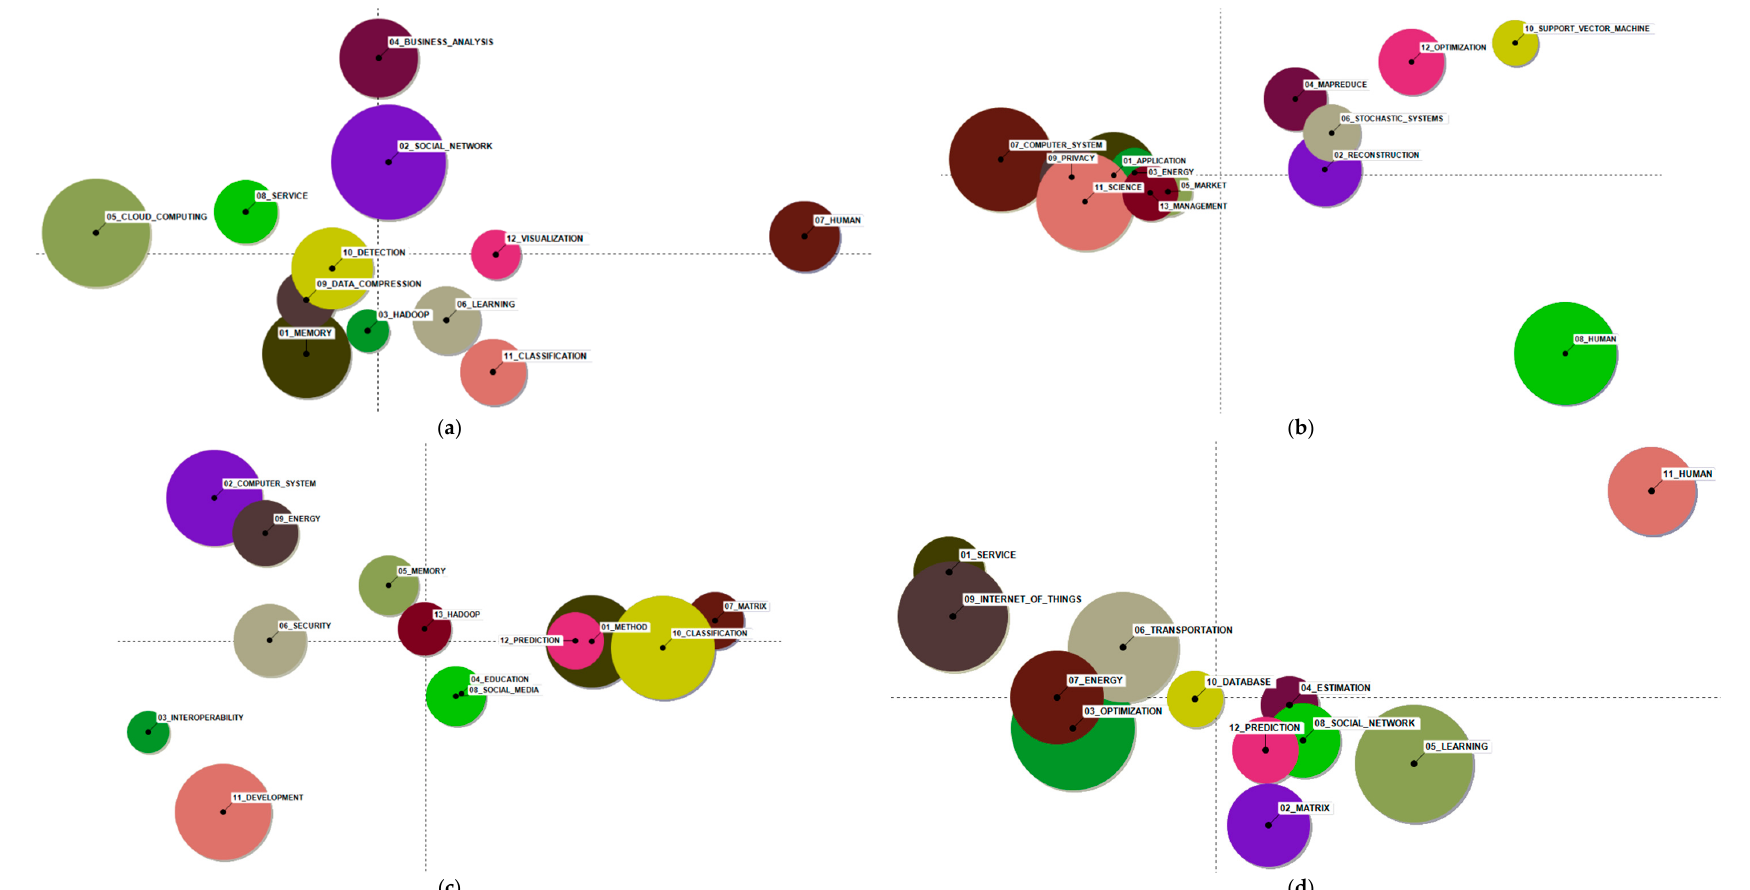
Figure C1. Keywords cluster visualization for each phase. ( a ) 2009–2015; ( b ) 2016; ( c ) 2017; ( d ) 2018.